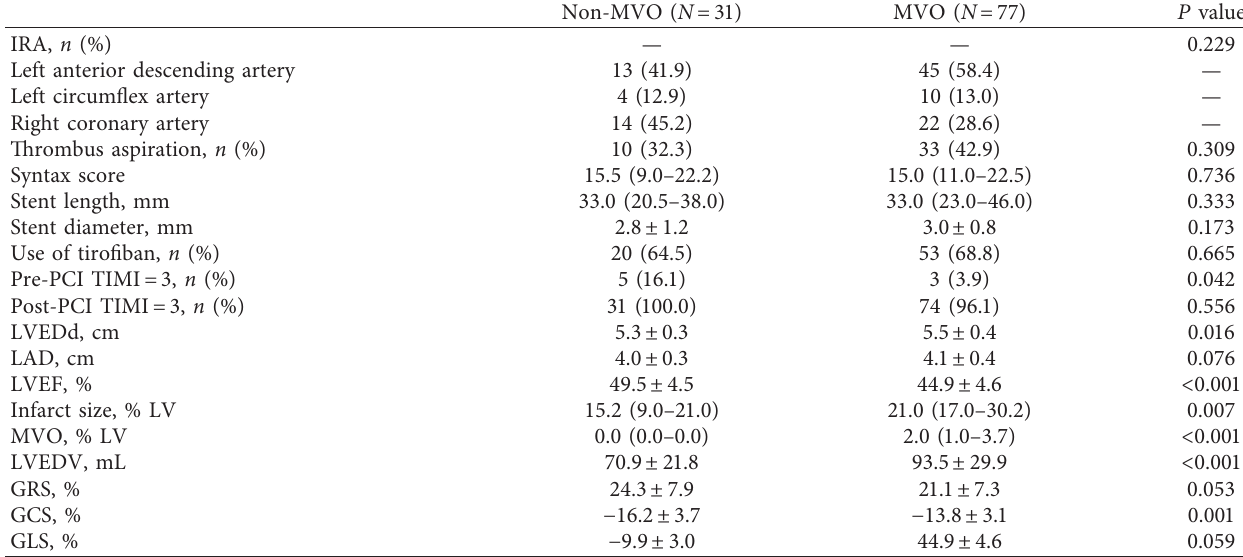
Table 2: Procedural, echocardiographic, and CMR parameters of the study